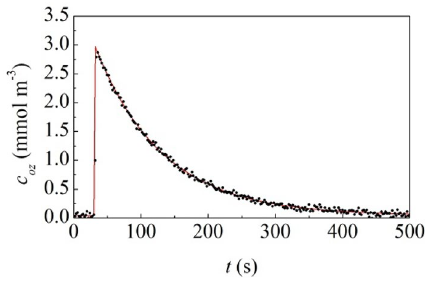
Figure 1. Measured O 3 concentration, c oz ( t ) , as a function of time, t . Data refer to experiments in which granite blocks were subjected to uniaxial compression until fracture occurred. The best-fitted curve is